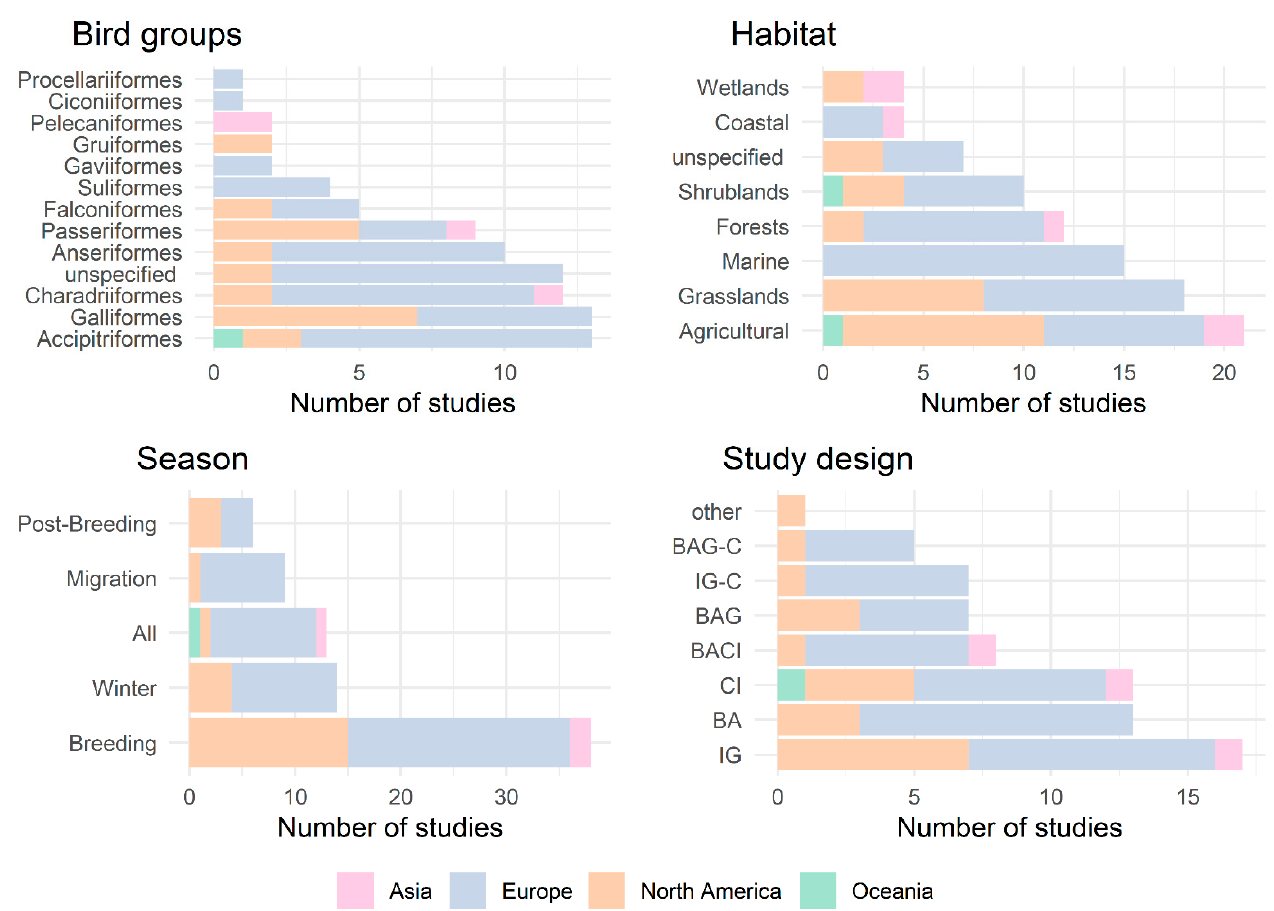
Figure 3. Number of studies distributed according to bird groups, habitat, phenological season and study design (BACI before-after-control-impact; BAG before-after-gradient; BAG-C before-after-gradient, with a control; IG impact-gradient; IG-C impact-gradient, with a control; BA before-after and CI control-impact) reviewed in this study ( n = 71) and discriminating between continents. Each study may be represented in more than one class (e.g., a study may focus on multiple bird groups and seasons).